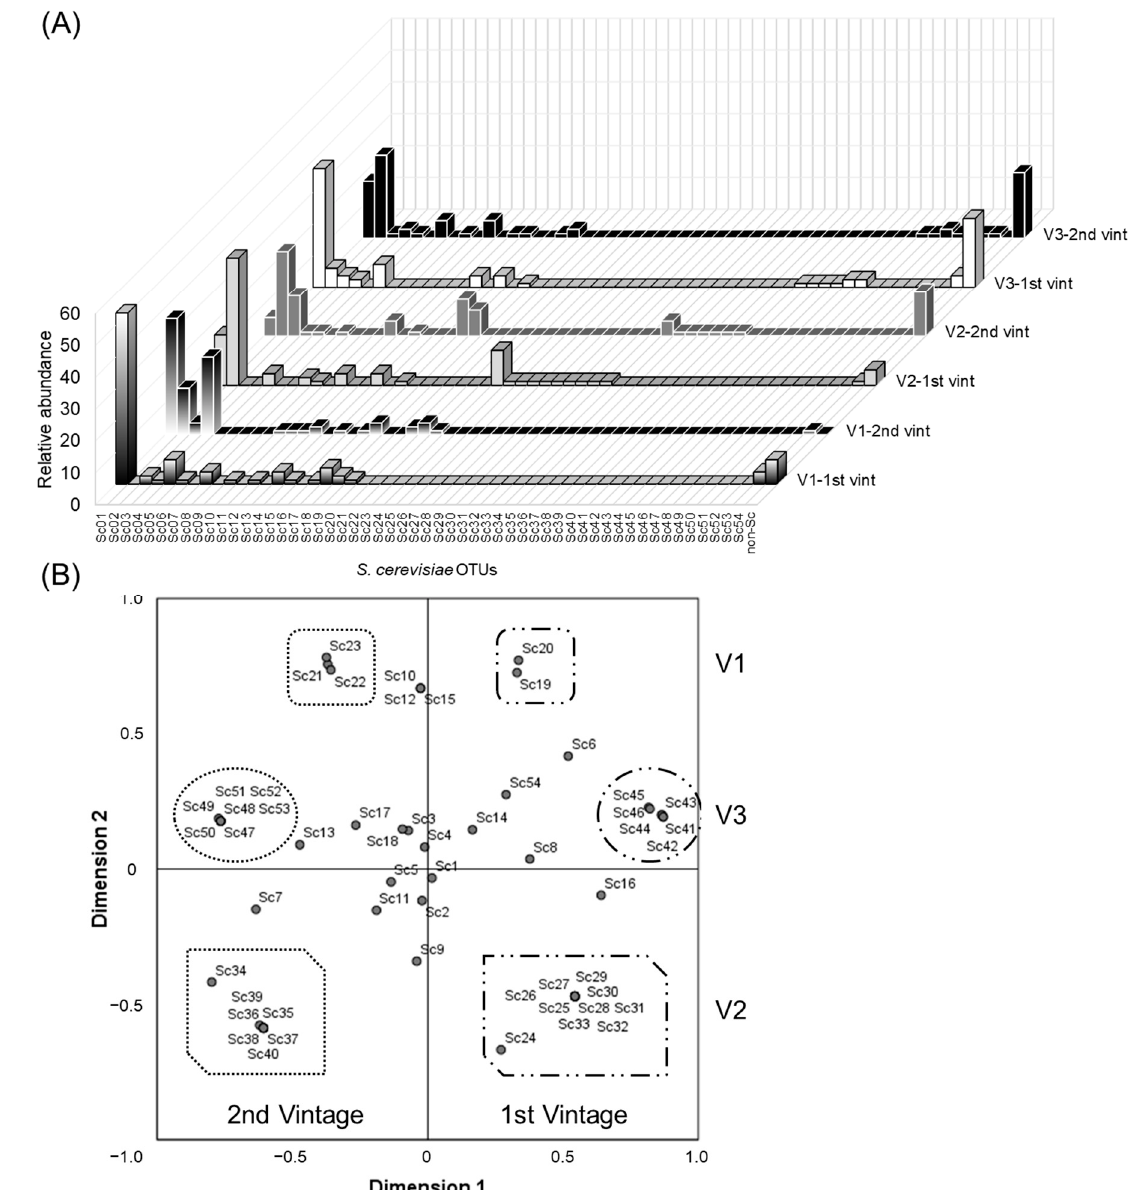
Figure 4. β diversity (yeast community dissimilarity). ( A ) S. cerevisiae populations established across the vineyards (V1, V2, V3) and the vintages (1st vint, 2nd vint). ( B ) Non-metric multidimensional scaling (NMDS) using Bray–Curtis distance. The S-stress value was 0.00772. The groups of strains representative of each vineyard population (V1, V2, V3) are delimitated by circles or rectangles forms, and the vintage populations (first and second) are distinguished by the different border in the forms (dots or dots and lines, respectively). Significant differences were found among samples ( p -value = 0.0001).